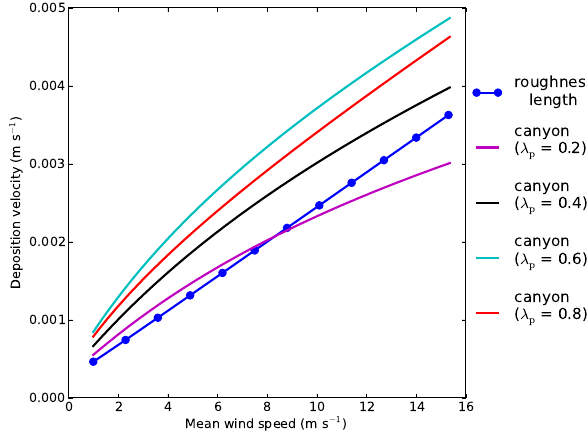
Figure 12. Time series of deposition rate (µgs − 1 ) of pollutants ( c = 1µgm − 3 ) for each surface and region in one chosen urban grid cell in November 2011.